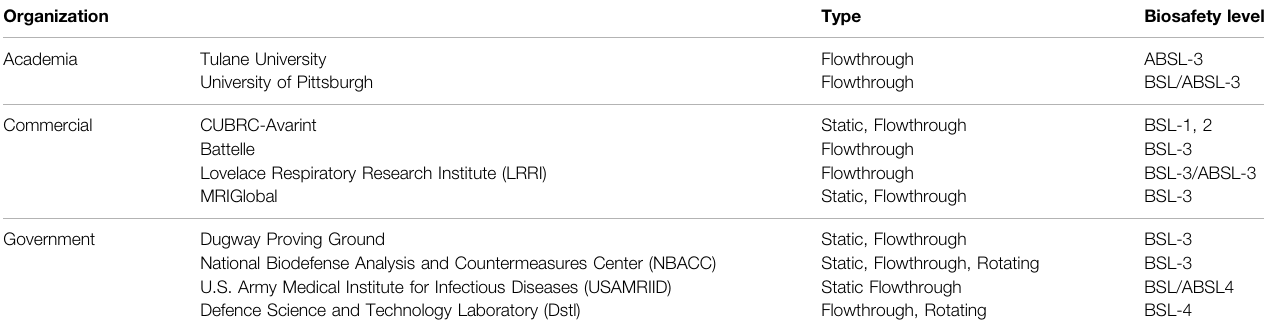
TABLE 1 | Representative set of aerosol test chambers. The list was derived from open source material.